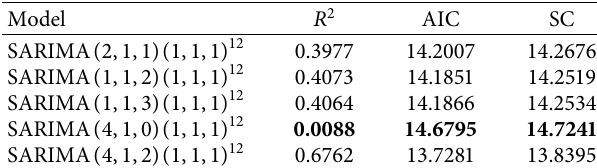
Table 2: Significance test of model